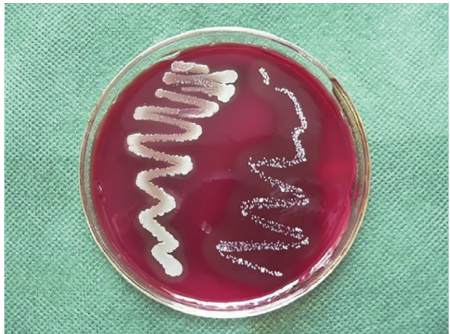
Figure 3: Culturing turbidity solutions in blood agar